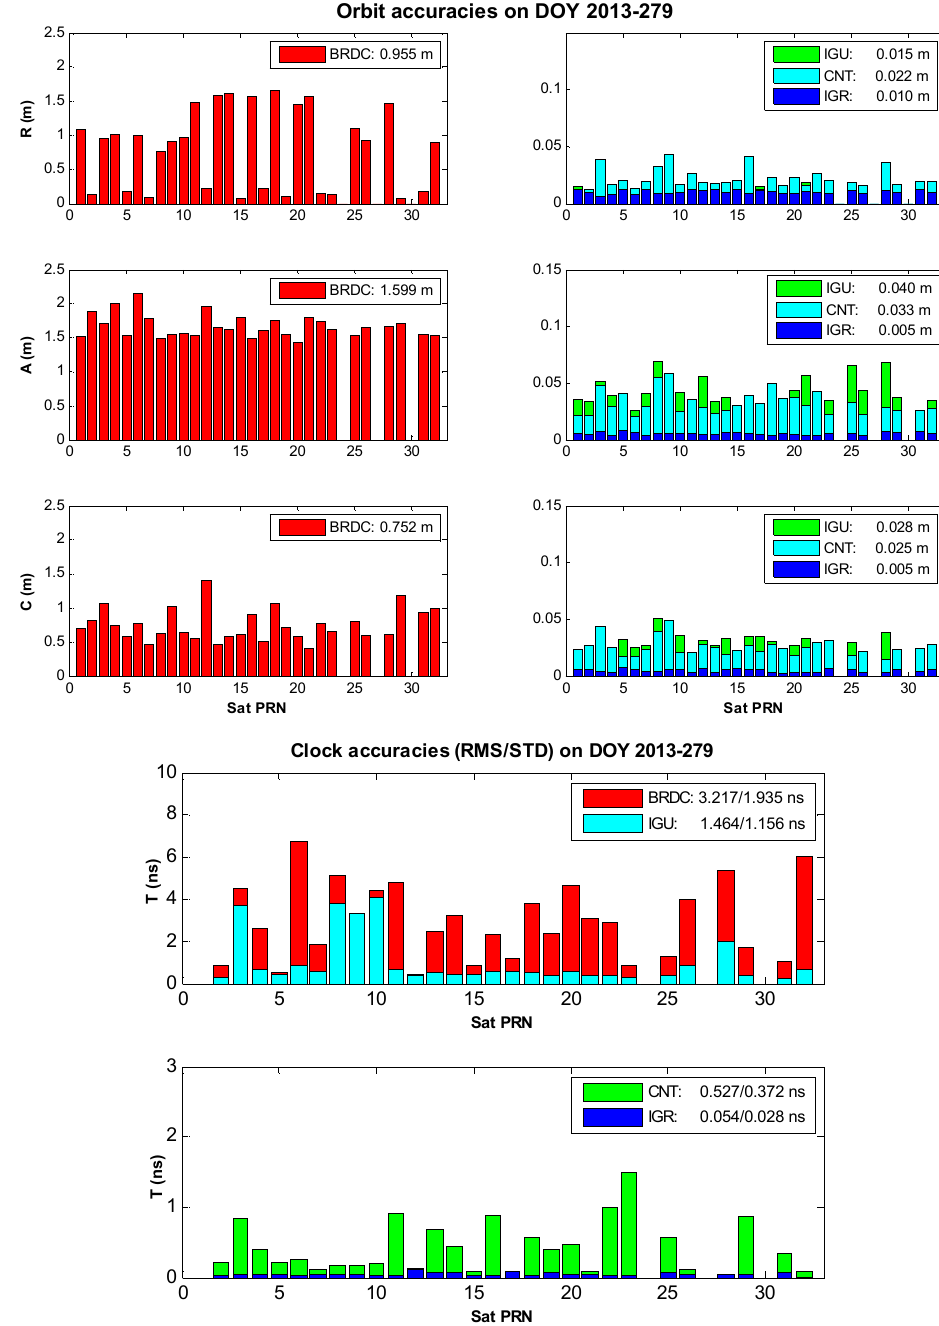
Figure 1. Orbit ( top ) and clock ( bottom ) accuracies of BRDC, IGU, CNT, and IGR satellite products with respect to the IGS final product on DOY 2013-279.